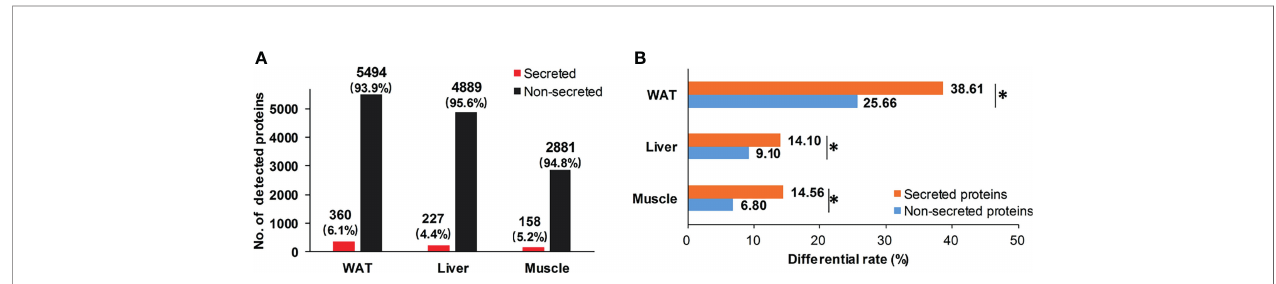
FIGURE 4 | Distribution of secreted proteins. (A) Distribution of secretory and non-secretory proteins in detecting pool; (B) Differential rate of secretory and non- secretory proteins. *P < 0.05, chi-square test.